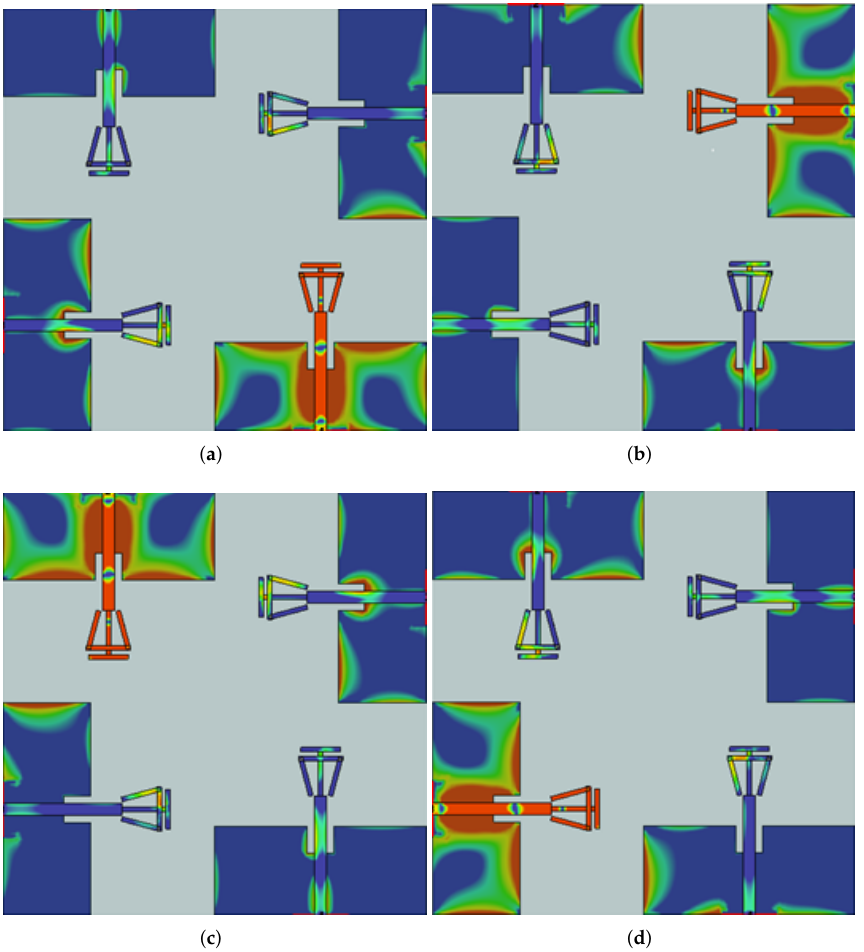
Figure 10. Surface current distribution for ( a ) antenna-1, ( b ) antenna-2, ( c ) antenna-3, and ( d )